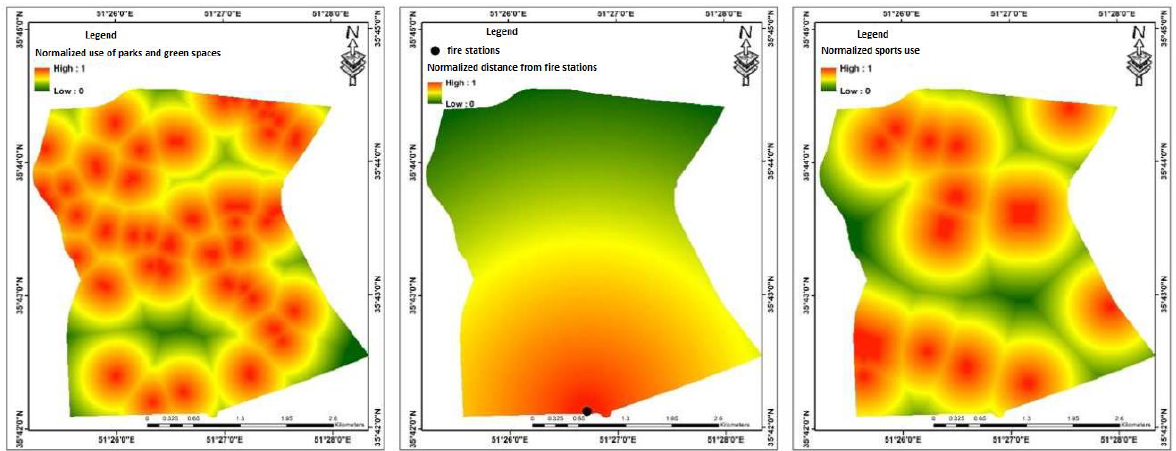
Figure 9. Fuzzy distance from compatible applications.